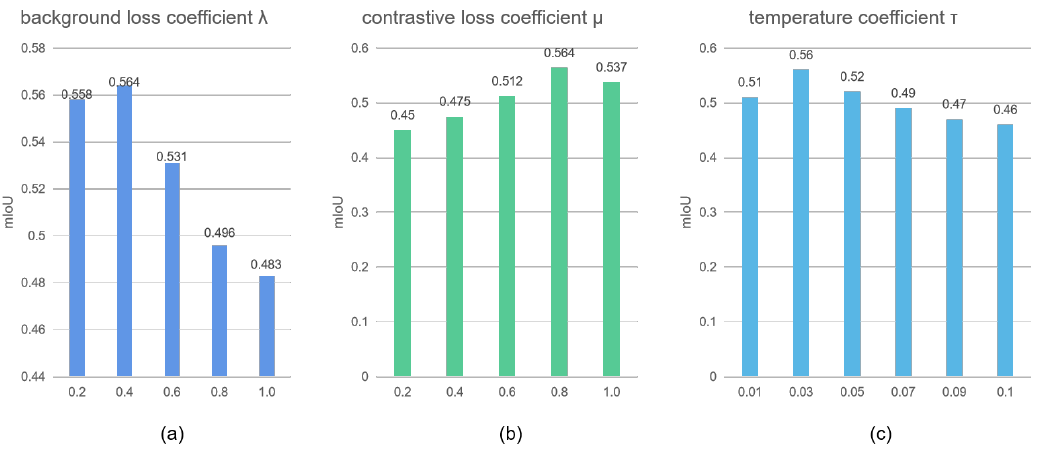
Figure 8. Comparative experimental results for different values of the hyperparameters. ( a ) µ is the coefficient before the loss function of the background learner. ( b ) λ is the coefficient before the contrast loss. ( c ) τ is the temperature coefficient in the contrast